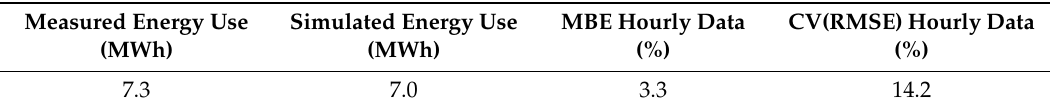
Figure 9. Measured (blue) and simulated (red) energy to the hydronic radiators per day including the difference percentage between measured and modelled energy during the unoccupied validation period. Table 6. Differences between simulated and measured energy to the hydronic radiators. One week hourly data, 29 December 2014 to 5 January 2015.